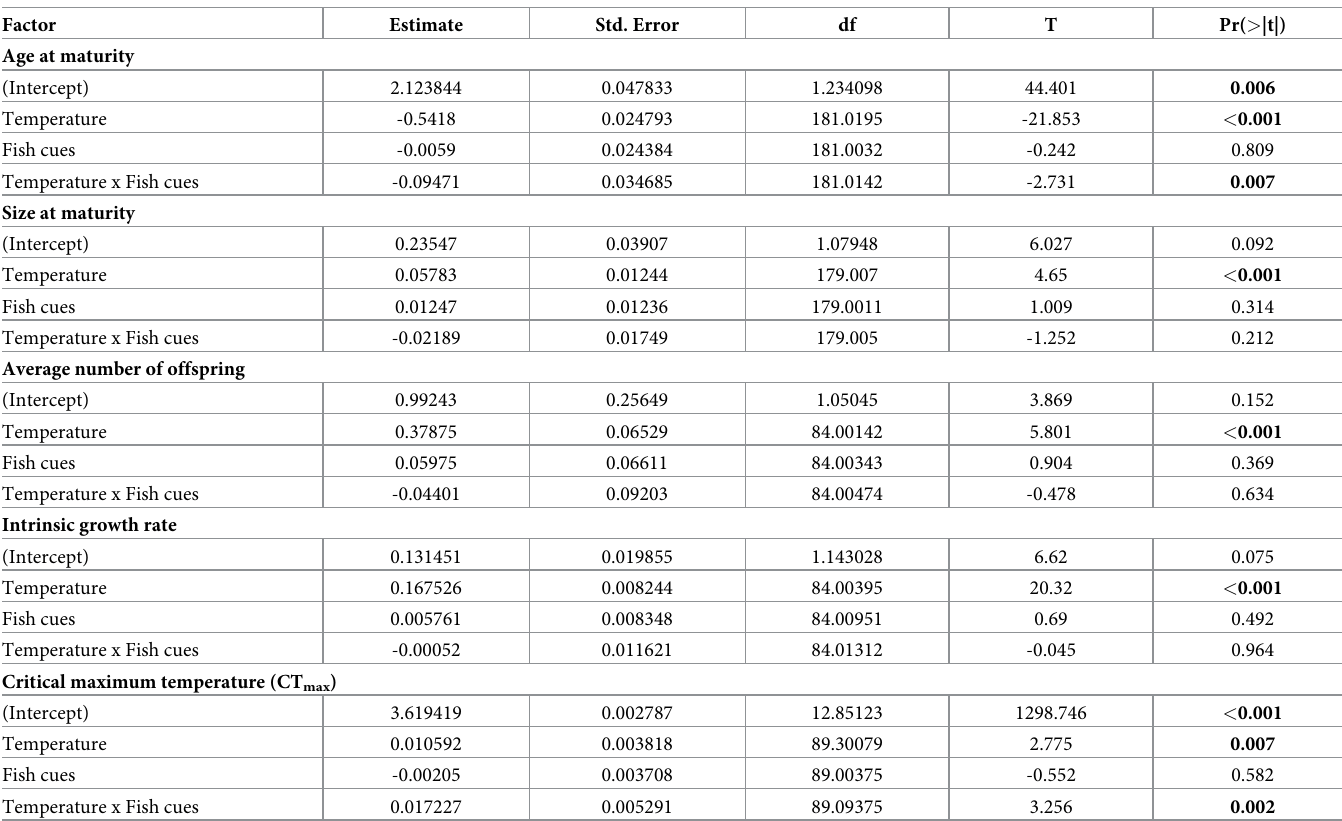
Table 1. Fixed-effect results of the general linear mixed-effect model analysis of the life-history traits of Daphnia pulicaria . Clonal lines were collected from Blue and Gardisky Lakes and reared under different temperature (15˚C or 25˚C) and fish cue treatments (presence or absence). A clone’s lake of origin was treated as a random